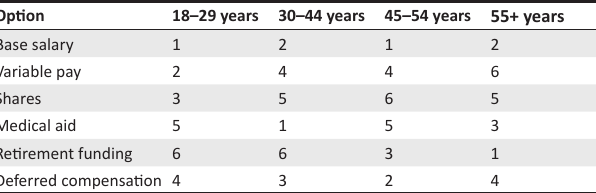
TABLE 1: Ranking of remuneration preferences by different age